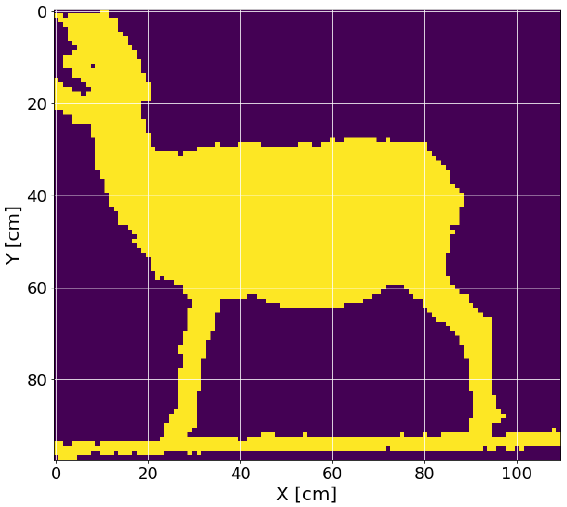
Figure 7. Two-dimensional image with the information on the X-axis and the Y-axis.